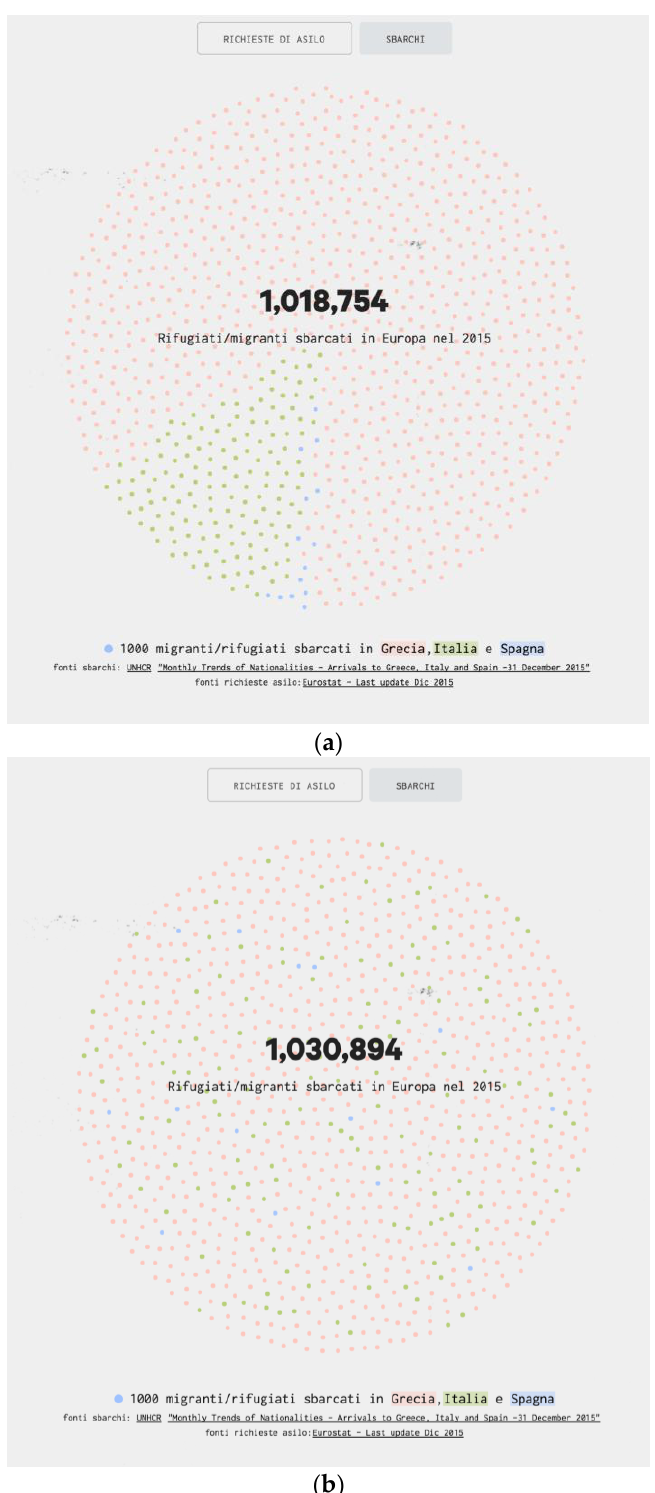
Figure 5. ( a ) The initial state of the visualization about the landings in a dot-based pie chart; ( b ) Due to the movement of the dots, the visualization turns into a disorderly